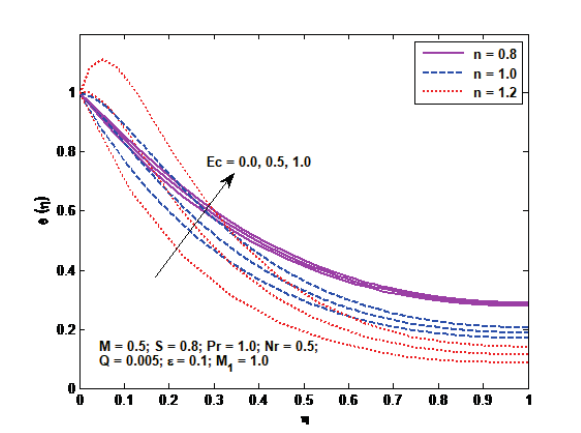
Fig. 12: Temperature profiles for different values of Ec